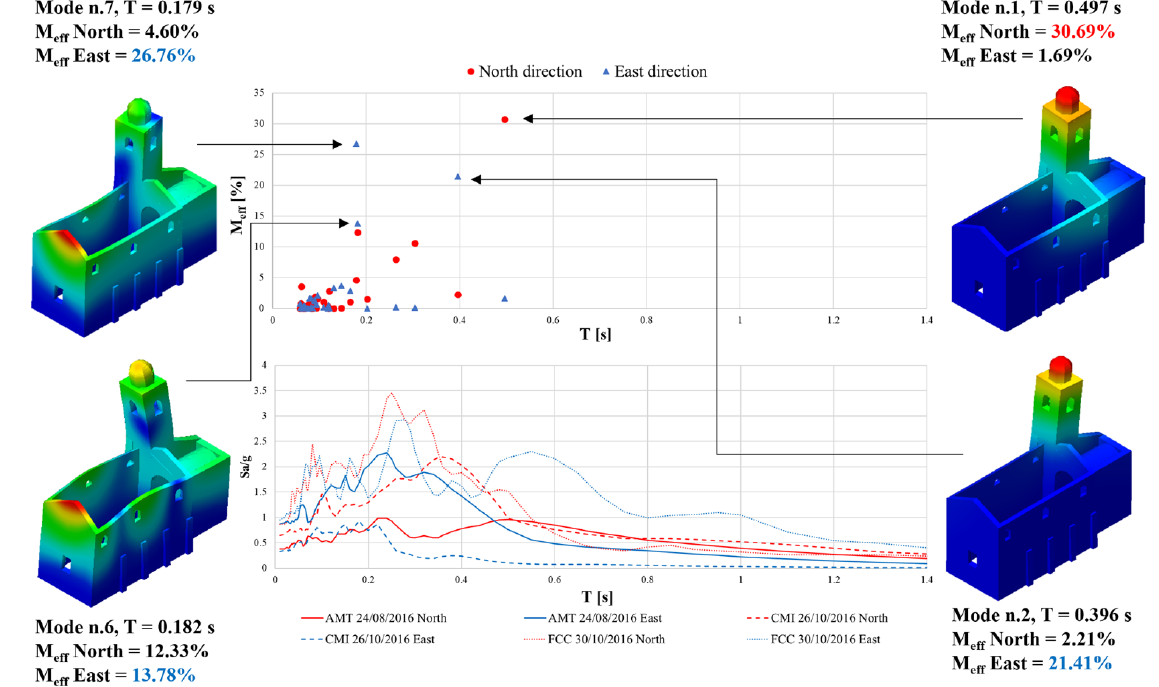
Figure 5. Distribution of modal shapes in the longitudinal and transversal directions and comparison with the pseudo- acceleration response spectra of the three main shocks of Central Italy seismic sequence of 2016 for San Francesco Church in Montefortino (Fermo, Central Italy). Buildings 2021 , 11 , x FOR PEER REVIEW